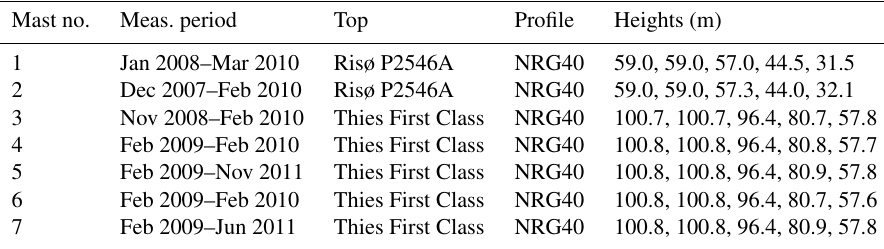
Table 1. Measurement period and instrumentation for each of the seven masts. Mast no. Meas.